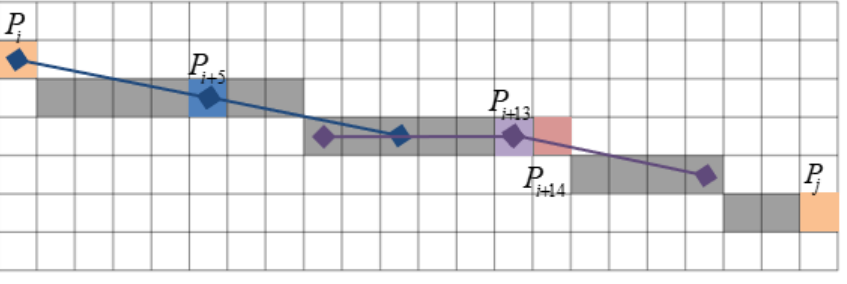
Figure 8. Effect of contour serration on chord dip angle. The front and back chord inclination angles at the tangent point in Figure 8 are in Table listed in Table 3.